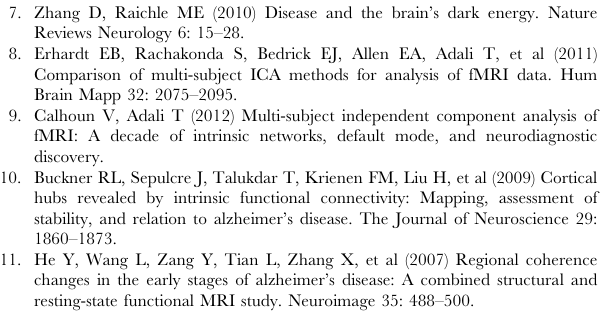
Figure S1 Schematic diagram of the breathing